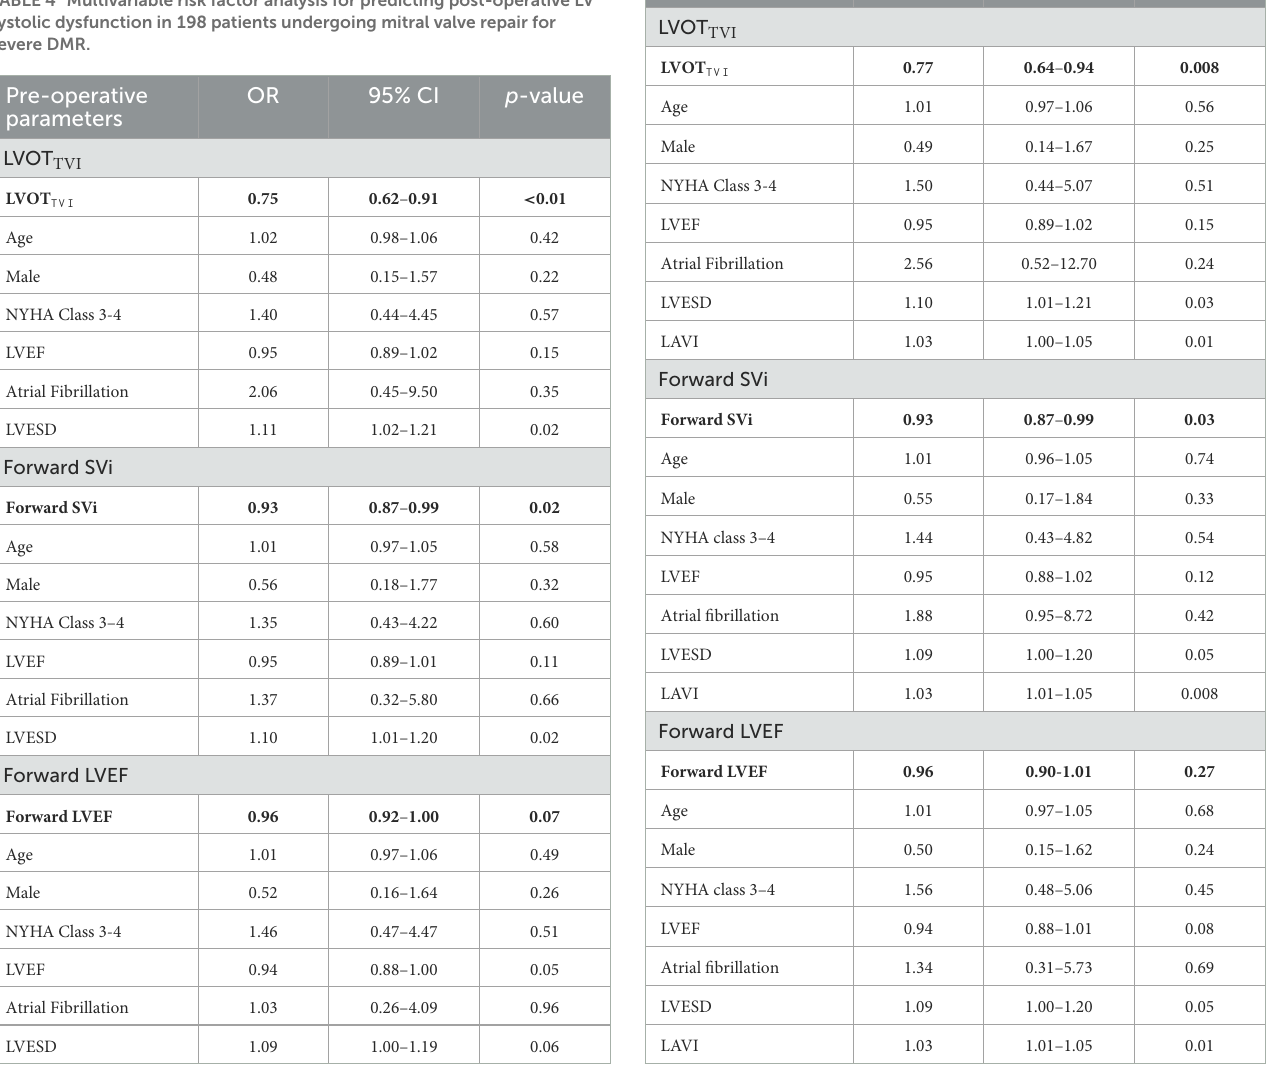
, forward Svi, TVI